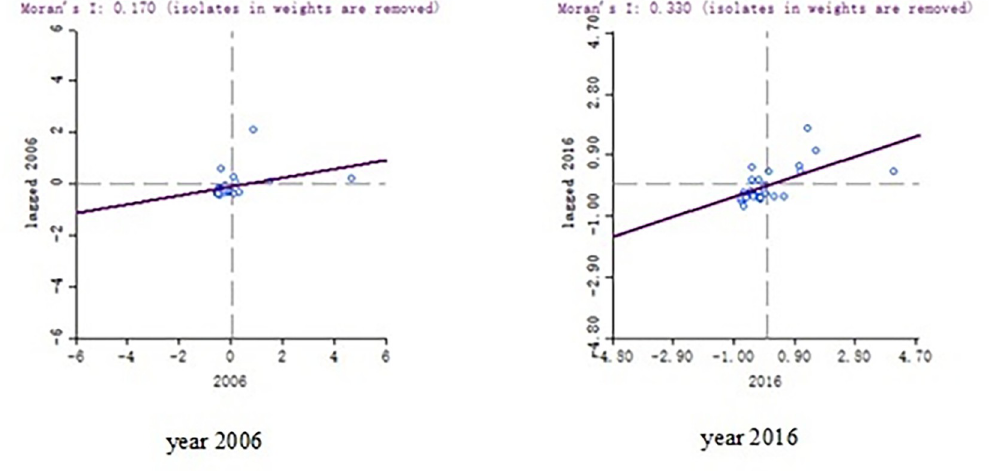
Fig 1. Moran’s I scatter diagram of spatial correlation of China’s high-quality economic development in 2006 and 2016.